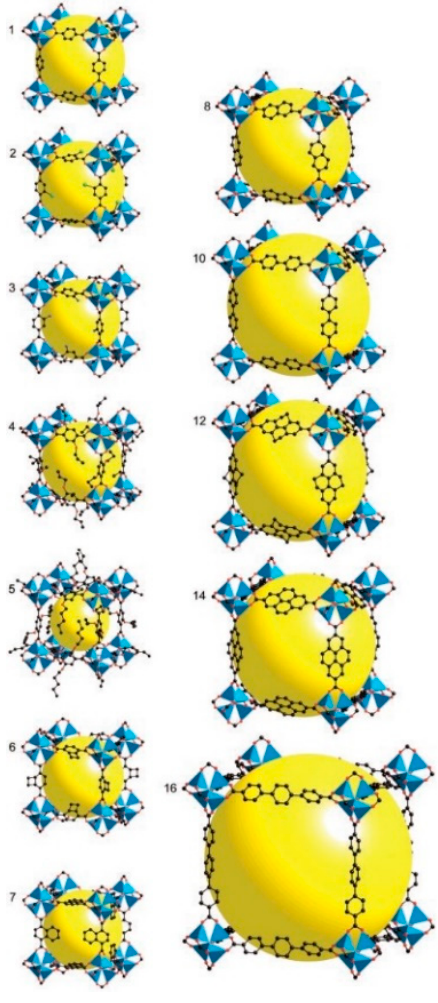
Figure 1. Isoreticular series of MOF-5 (IRMOF-1). Crystal structures of the IRMOFs-n (n = 1, 7, 8, 10, 12, 14, and 16), labeled respectively. The color scheme is as follows: Zn (blue polyhedra), O (red spheres), C (black spheres), Br (green spheres in 2), amino-groups (blue spheres in 3). The large yellow spheres represent the largest van der Waals spheres that would fit in the cavities without touching the frameworks. Reprinted with permission from [73]. Copyright © 2002, American Association for the Advancement of Science. All rights reserved.